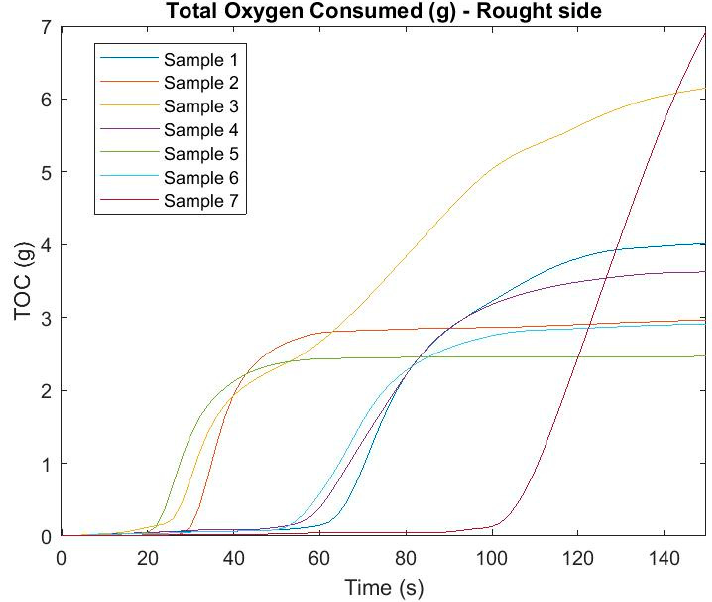
Figure 7. Total oxygen consumed (g) in time—rough side.